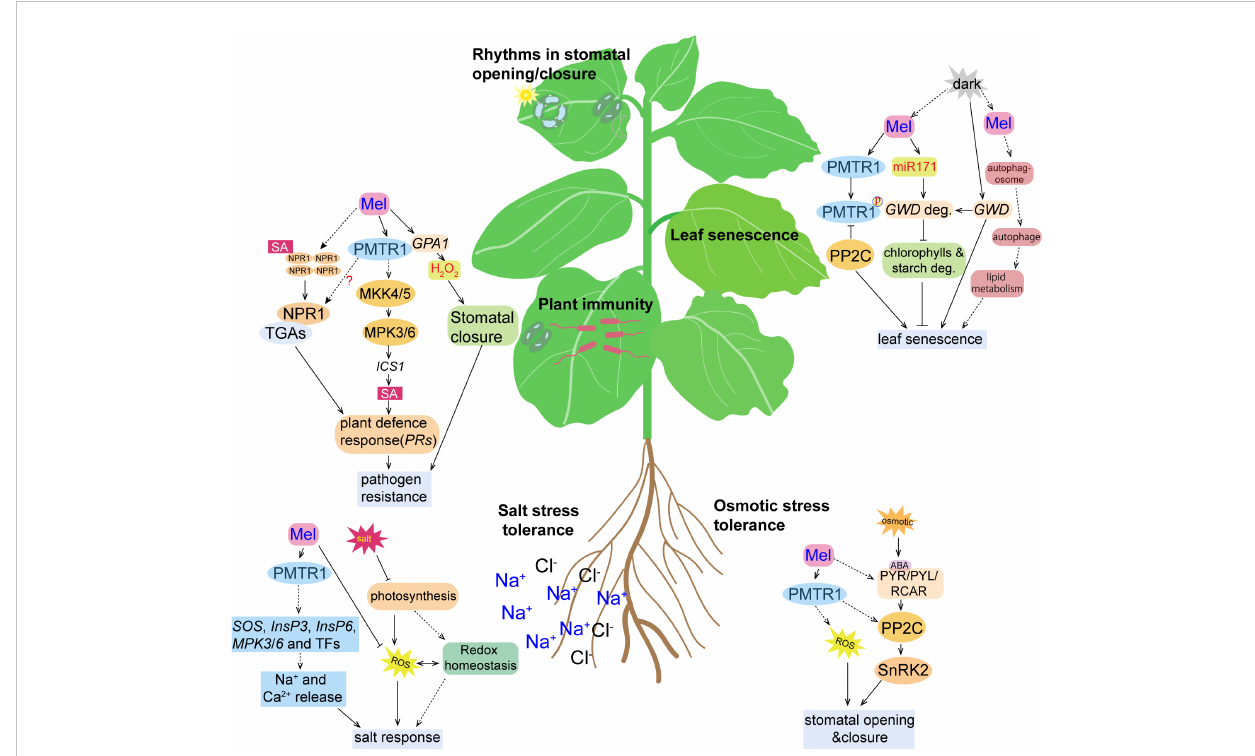
FIGURE 3 Cartoon illustration of the activity of phytomelatonin and the PMTR1-mediated signaling pathways under different stress conditions. High salinity results in the inhibition of photosynthesis, accumulation of reactive oxygen species (ROS), and the disruption of redox homeostasis, all of which were alleviated by phytomelatonin treatment. Under salt stress conditions, phytomelatonin is perceived by its PMTR1 receptor, which induces the expression of genes encoding SOS , InsP3 , InsP6 , MPK3 , and MPK6 , as well as the expression of other transcription factors, leading to the release of Na + and Ca 2+ and enhancing the plant responses to salt stress. Under osmotic conditions, the plant stress signaling hormone abscisic acid (ABA) is accumulated and binds to its receptor PYR/PYL/RCAR, which may, in turn, activate SnRK2s. The activated SnRK2s regulates the expression of ABA- responsive genes through ABA-responsive element (ABRE) binding protein/ABRE binding factor (AREB/ABF) transcription factors. Phytomelatonin likely regulates plant adaptation to osmotic stress through interactions with PP2C by using PMTR1 to activate ABA-dependent signaling pathways. Phytomelatonin can also induce stomatal closure to prevent water loss and enhance plants ’ tolerance to osmotic stress. Upon pathogen infection, the PMTR1-mediated activation of MKK4/5 and the subsequent phosphorylation of MPK3/6 can result in the upregulation of genes encoding the salicylic acid (SA) pathway, which contribute to pathogen resistance. Phytomelatonin may also trigger the translocation of NPR1 from the cytosol to the nucleus, where it activates the expression of defense genes. Phytomelatonin can also mediate NADPH-dependent H 2 O 2 production to close the stomata, thereby restricting pathogen infection. Upon darkness exposure, the expression of GWD , a gene responsible for starch degradation, and the accumulation of the GWD protein are induced, which promotes starch degradation. Phytomelatonin can inhibit leaf senescence by inducing the expression of miR170 , which targets GWD for degradation. In dark conditions, the phytomelatonin signals can also be perceived by PMTR1 to initiate unknown downstream signaling to inhibit leaf senescence. PP2C can interact with and dephosphorylate PMTR1 to fi ne-tune phytomelatonin signaling. However, it can also interact with MeRAV1, MeRAV2, and MeWRKY20 to inhibit the transcriptional activation of MeRAV1/2 and MeWRKY20 on the phytomelatonin biosynthetic